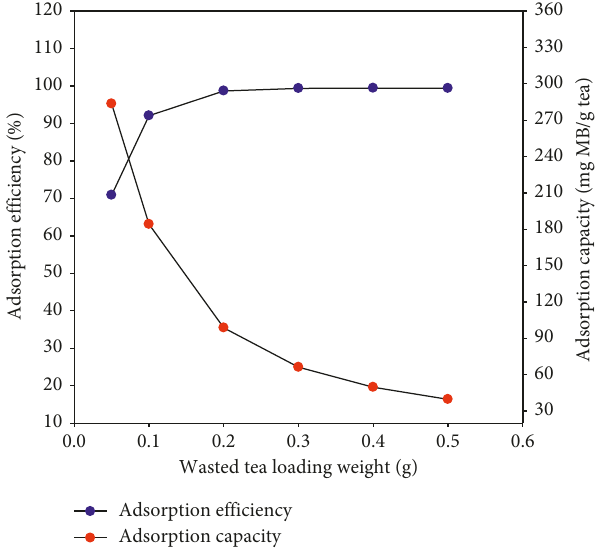
Figure 5: Effect of wasted tea loading weight on the adsorption efficiency and capacity of MB.